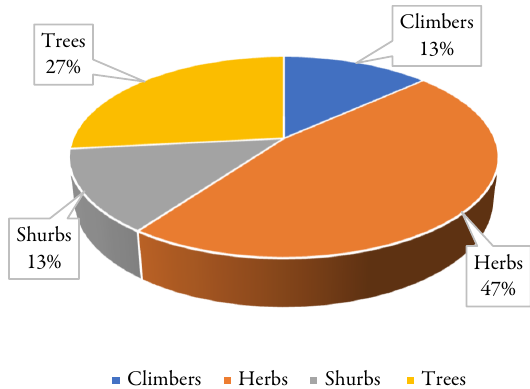
Figure 3. Life forms of the medicinal plants used by Monpas of Arunachal Pra